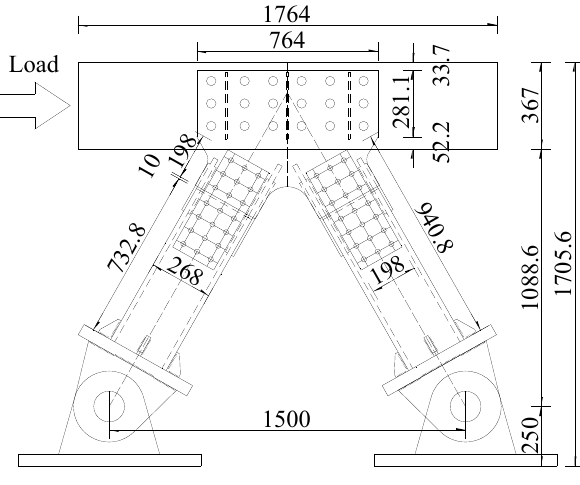
Figure 1. The most unfavorable joint (unit: m). E9: the ninth joint of the lower chord from left to right.